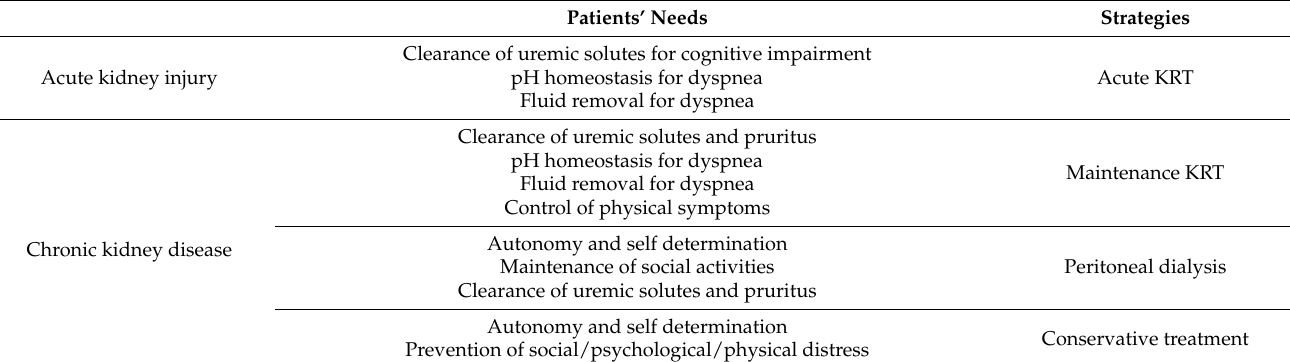
Table 1. AKI and CKD patients’ needs and